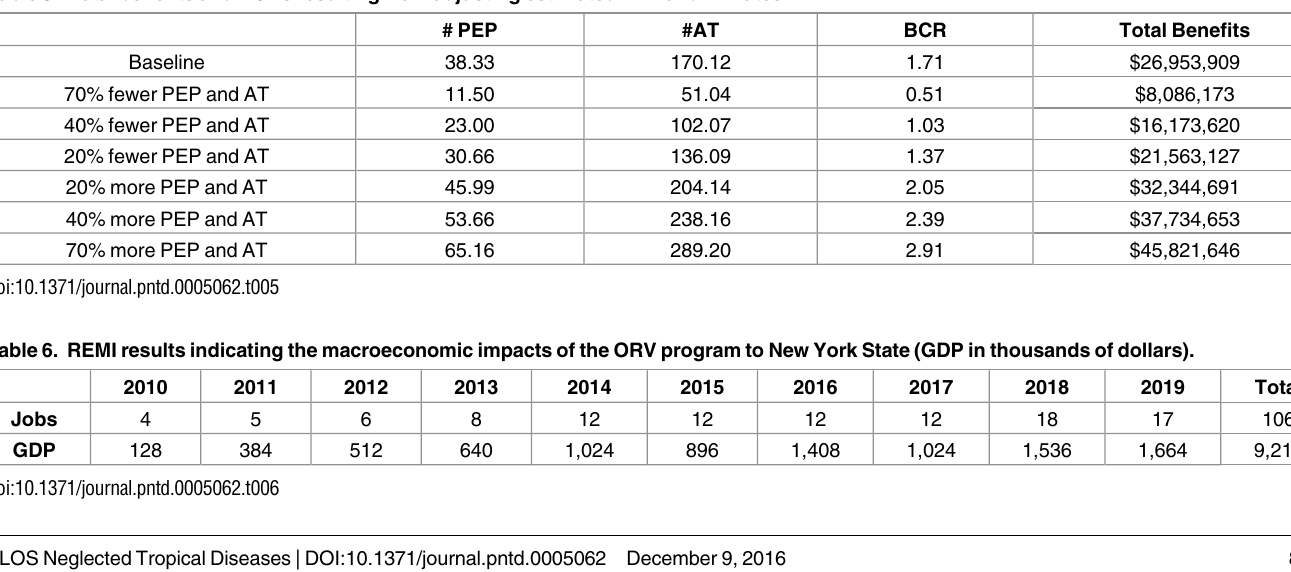
spending resulting from avoided PEPs and ATs (Table 6). This takes into account the spending